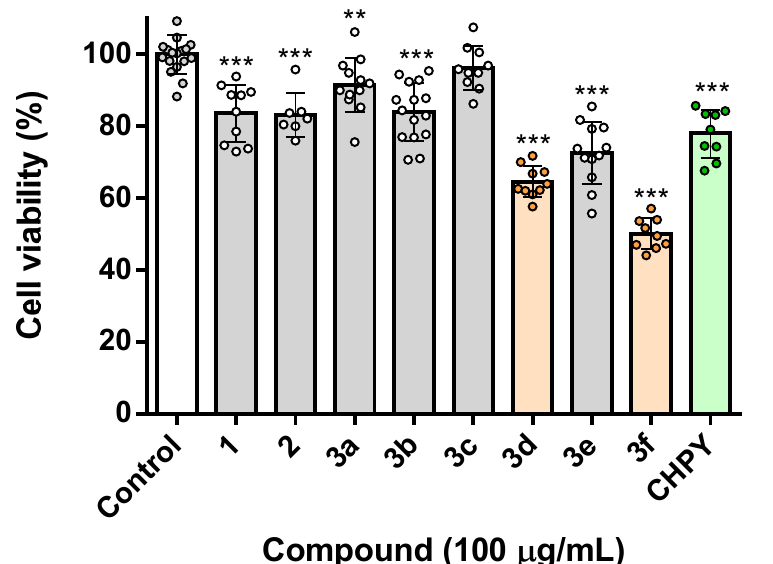
Figure 1. Viability of the Sf9 cells after incubation with the presented molecules (100 µg/mL), medium (control), or the reference insecticide chlorpyrifos (CHPY, 100 µg/mL). Cells were incubated for 24 h, after which viability was evaluated. ** p < 0.01, *** p < 0.001.